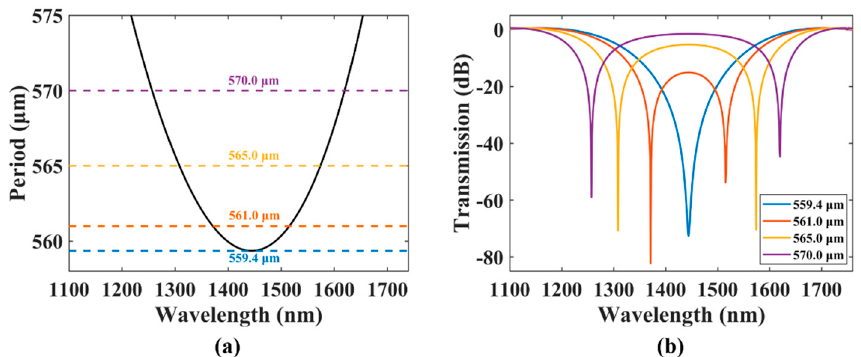
Figure 2. ( a ) The LPFG period versus the wavelength variation curve. ( b ) The LPFG transmission spectra with different periods. Table 2. Characteristic parameters of simulated spectra corresponding to different periods of the LPFG.